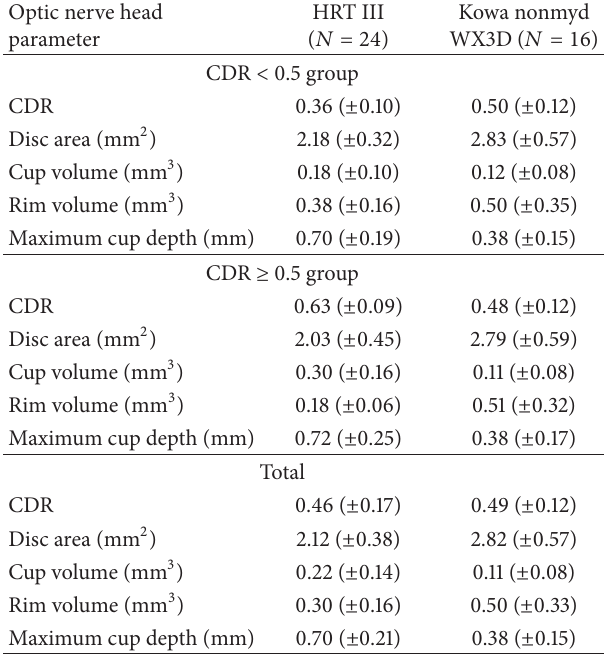
Table 1: Comparison and distribution of stereometric optic nerve head parameters assessed with HRT III and Kowa nonmyd WX3D for all investigated patients subdivided in two groups according to their CDR (cut-off value 0.5) and in total. Values are expressed as mean ( ± standard deviation,